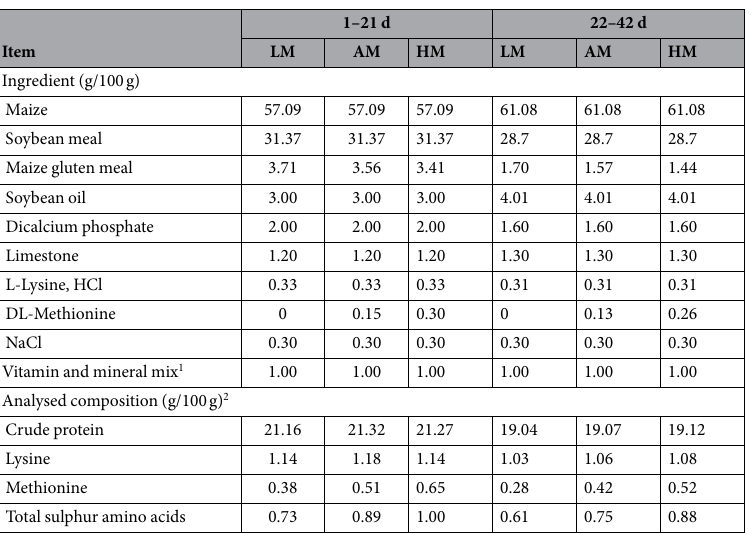
Table 4. Ingredients and nutrient composition of experimental diets (as-fed basis). 1 The premix provided the following nutrients per kilogram of diet: retinyl acetate, 10000 IU; cholecalciferol, 3000 ICU; all-rac- α -tocopherol acetate, 30 IU; menadione, 1.3 mg; thiamin, 2.2 mg; riboflavin, 8 mg; nicotinamide, 40 mg; choline chloride, 600 mg; calcium pantothenate, 10 mg; pyridoxine·HCl, 4 mg; biotin, 0.04 mg; folic acid, 1 mg; cobalamin, 0.013 mg; Fe (as FeSO 4 .H 2 O), 80 mg; Cu (as CuSO 4 .5H 2 O), 8 mg; Mn (as MnSO 4 .H 2 O), 110 mg; Zn (as ZnO), 65 mg; I (as KIO 3 ), 1.1 mg; Se (as Na 2 SeO 3 ), 0.3 mg. 2 The nutrient composition was analyzed in triplicate for each diet, and average values were